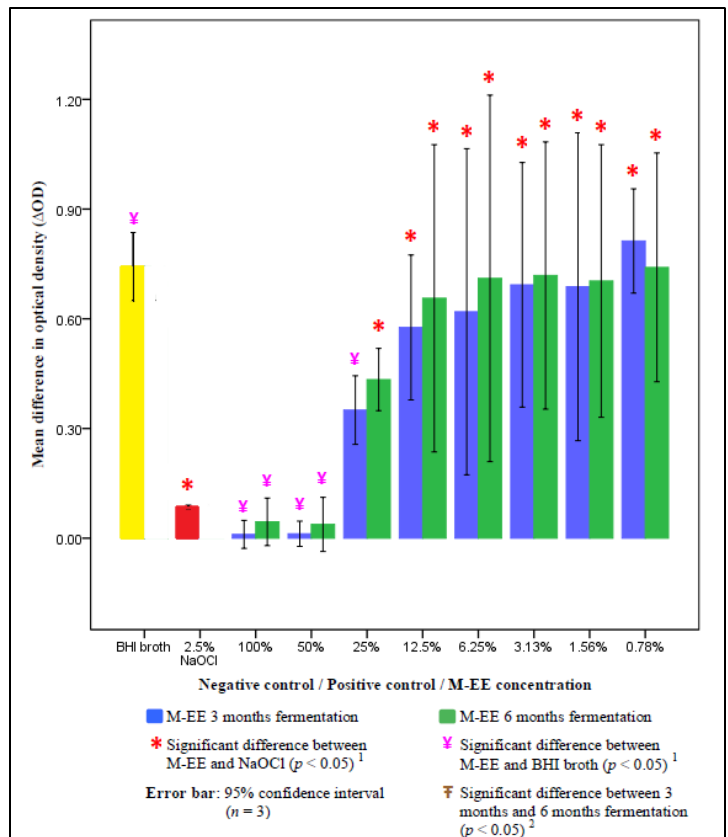
Figure 3. Mean difference in optical density between M-EE of different concentrations at 3 and 6 months fermentation, NaOCl, and BHI broth. 1 One-way analysis of variance (ANOVA): Difference between M-EE, NaOCL, and brain-heart infusion (BHI) broth ( p < 0.05). 2 Independent-samples T-test: Difference between fermentation periods ( p < 0.05).